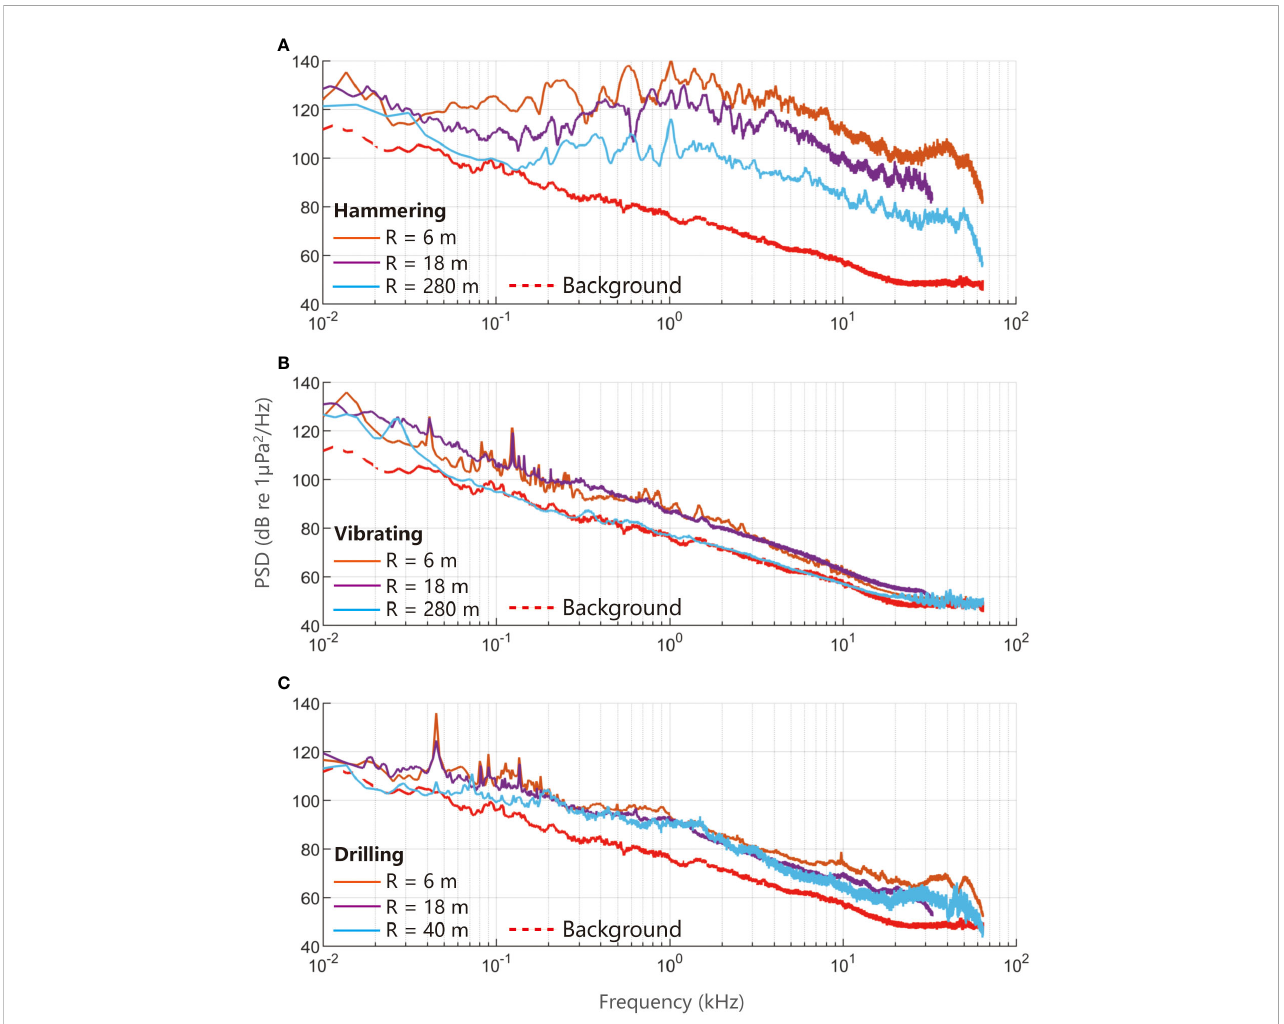
FIGURE 4 Spectrum diagrams of hammering noise (A) , vibrating noise (B) , and drilling noise (C) that measured at the station 1 (6 m from the source, R = 6 m), station 2 (R = 18 m) and station 3 (R = 280 m for hammering and vibrating noise, R = 40 m for drilling noise) during OED. The spectrum diagrams in sound pressure power spectral density (PSD) level were generated with Welch ’ s method (Welch, 1967), using 65,536 sample hamming windows with 80%